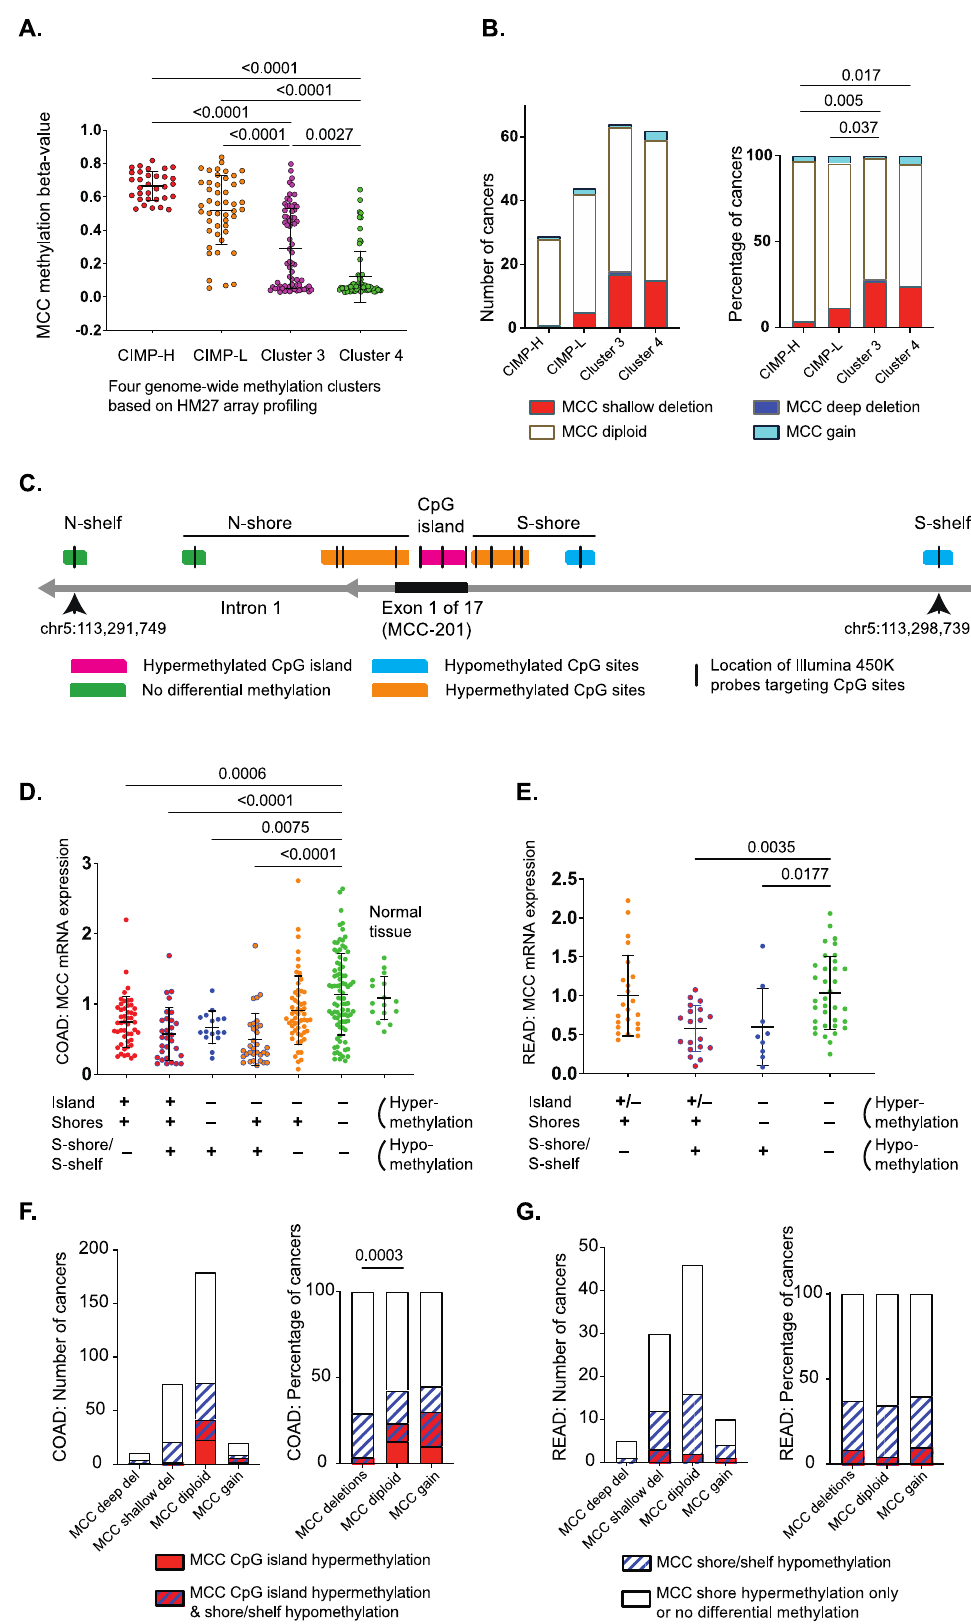
Figure 1. Genomic data from TCGA colorectal carcinomas shows MCC gene down-regulation is associated with hypermethylation of the CpG island or hypomethylation of the S-shelf/shore (data